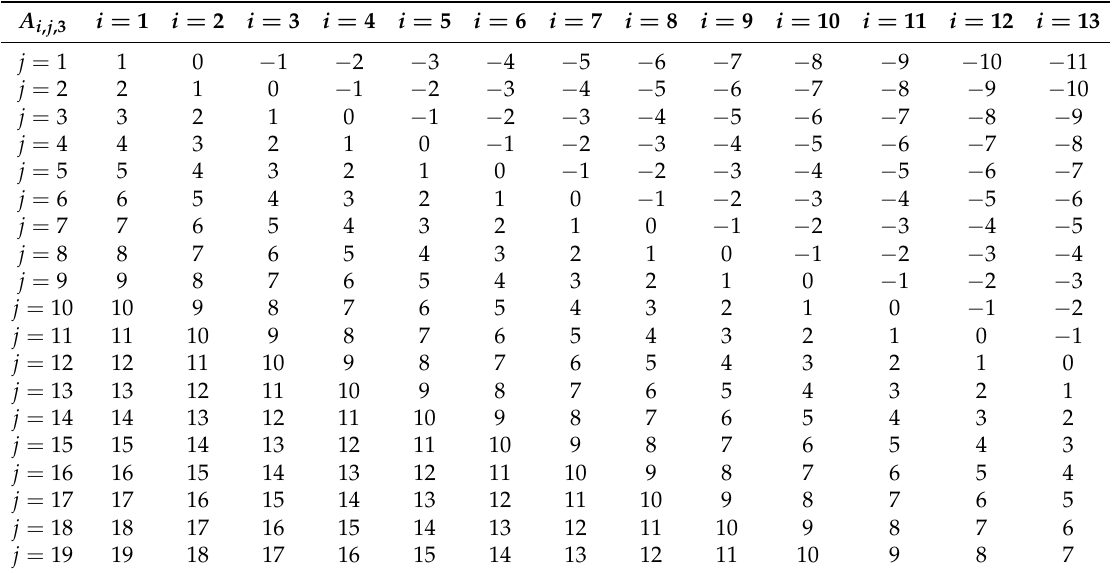
Table A4. Storage time of an assembly of OL3 belonging to the removal i ∈ I in the period j ∈ J A i , j ,3 . A i , j ,3